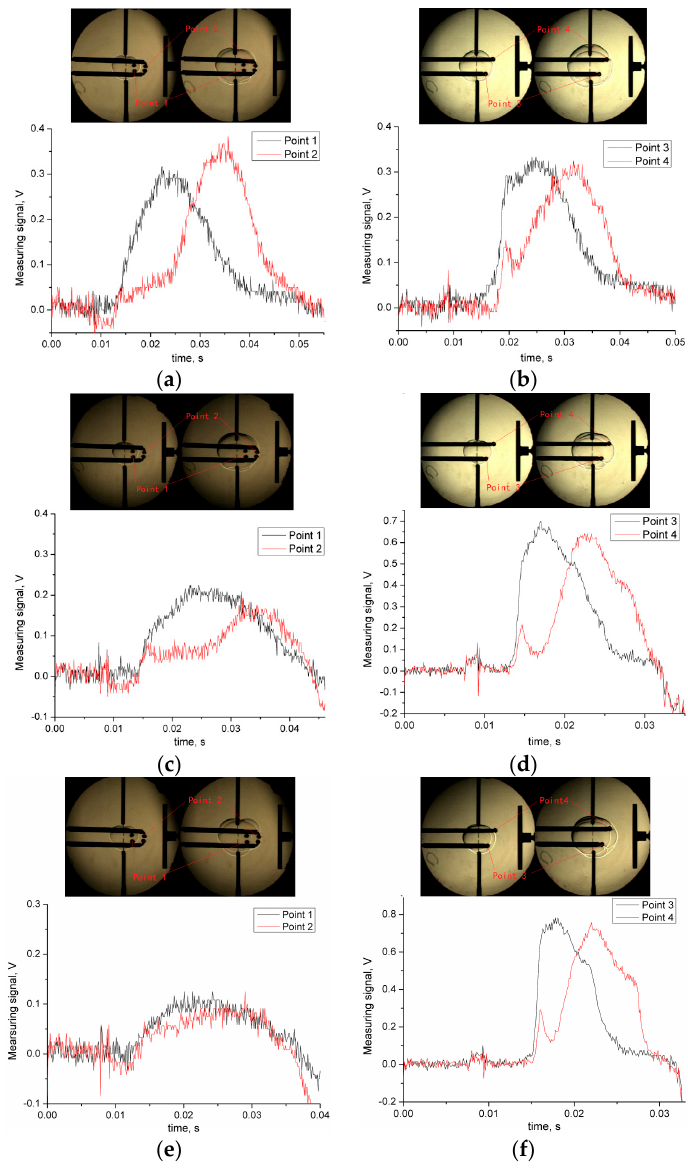
Figure 8. Ionic signal with flame position: ( a ) 0 kV center; ( b ) 0 kV side; ( c ) − 2.5 kV center; ( d ) − 2.5 kV side; ( e ) − 5 kV center; and ( f ) − 5 kV side.